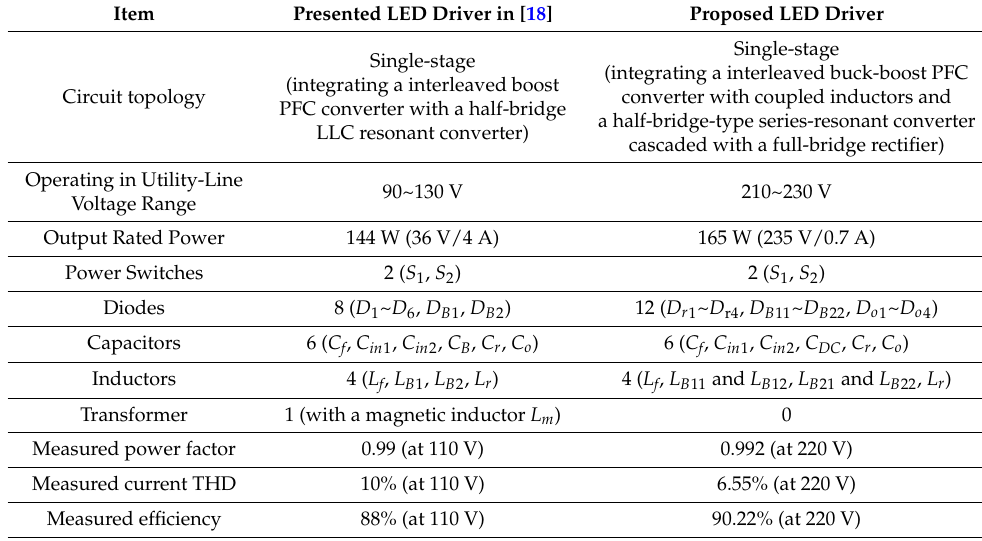
Table 5. Comparisons between the existing single-stage LED driver for streetlight applications in [18] and the proposed one.